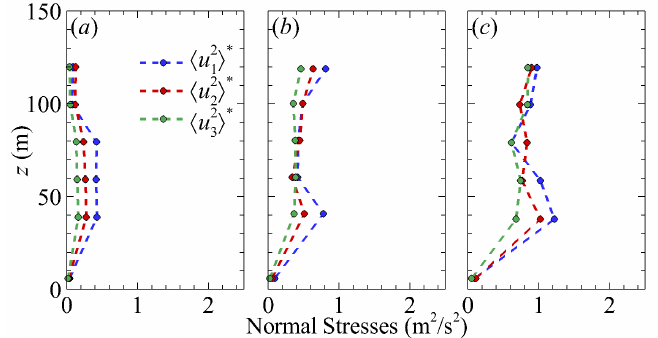
Figure 15. Vertical profiles of the normal components of the Reynolds stress tensor measured during